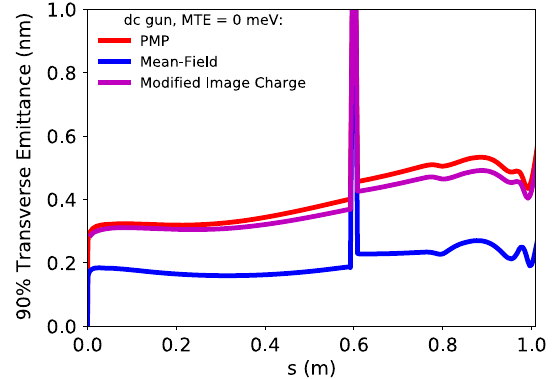
FIG. 16. Transverse normalized rms emittance comparison for point-to-point, mean-field, and modified image charge simula- tions of the dc UED beam line with 0 meV MTE.